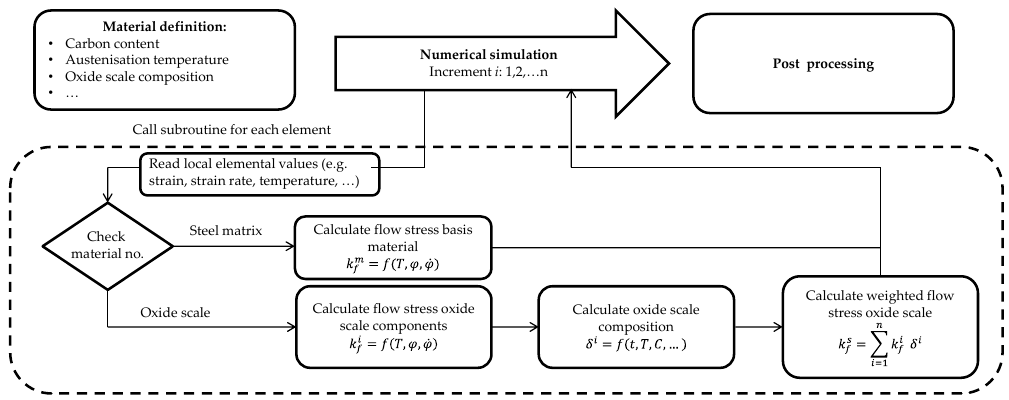
Figure 4. Dataflow inside the user subroutine as well as between the user subroutine and the numerical solver.